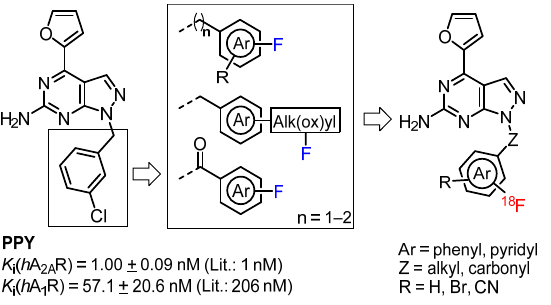
Figure 3. Lead compound PPY and illustration of approached strategies towards novel 18 F-labeled derivatives.